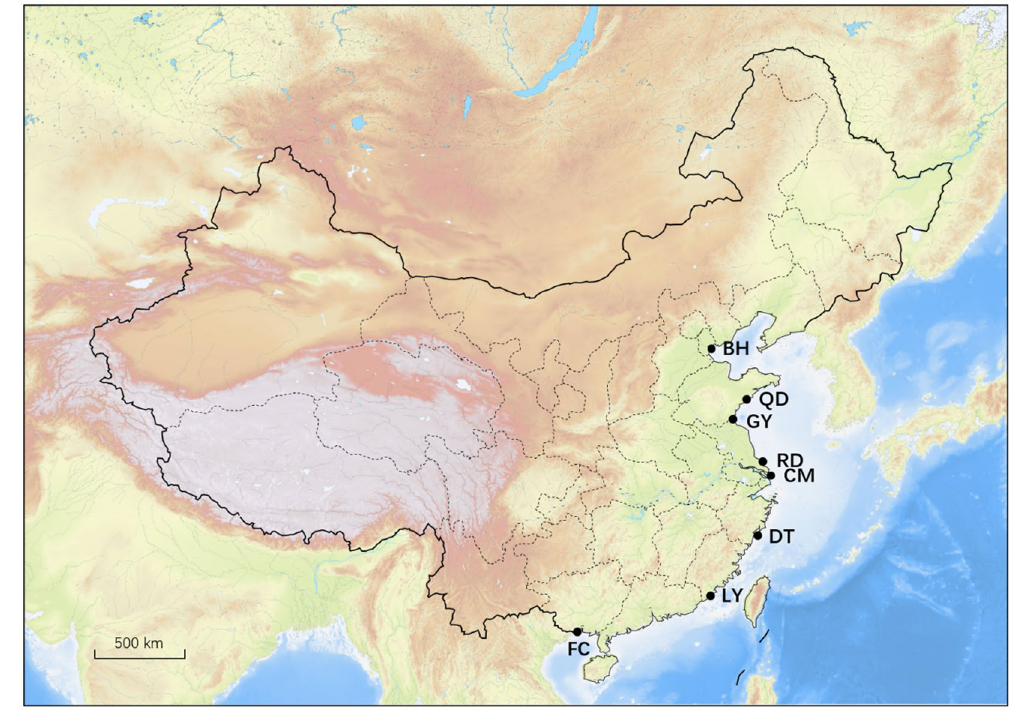
Figure 4. Geographical locations of the eight L. maculatus populations (generated by software BIGEMAP version 29.1.4.0, URL link: http:// www. bigem ap. com/). BH Binhai, QD Qingdao, GY Ganyu, RD Rudong, CM Chongming, DT Dongtou, LY Lieyu, FC Fangcheng.